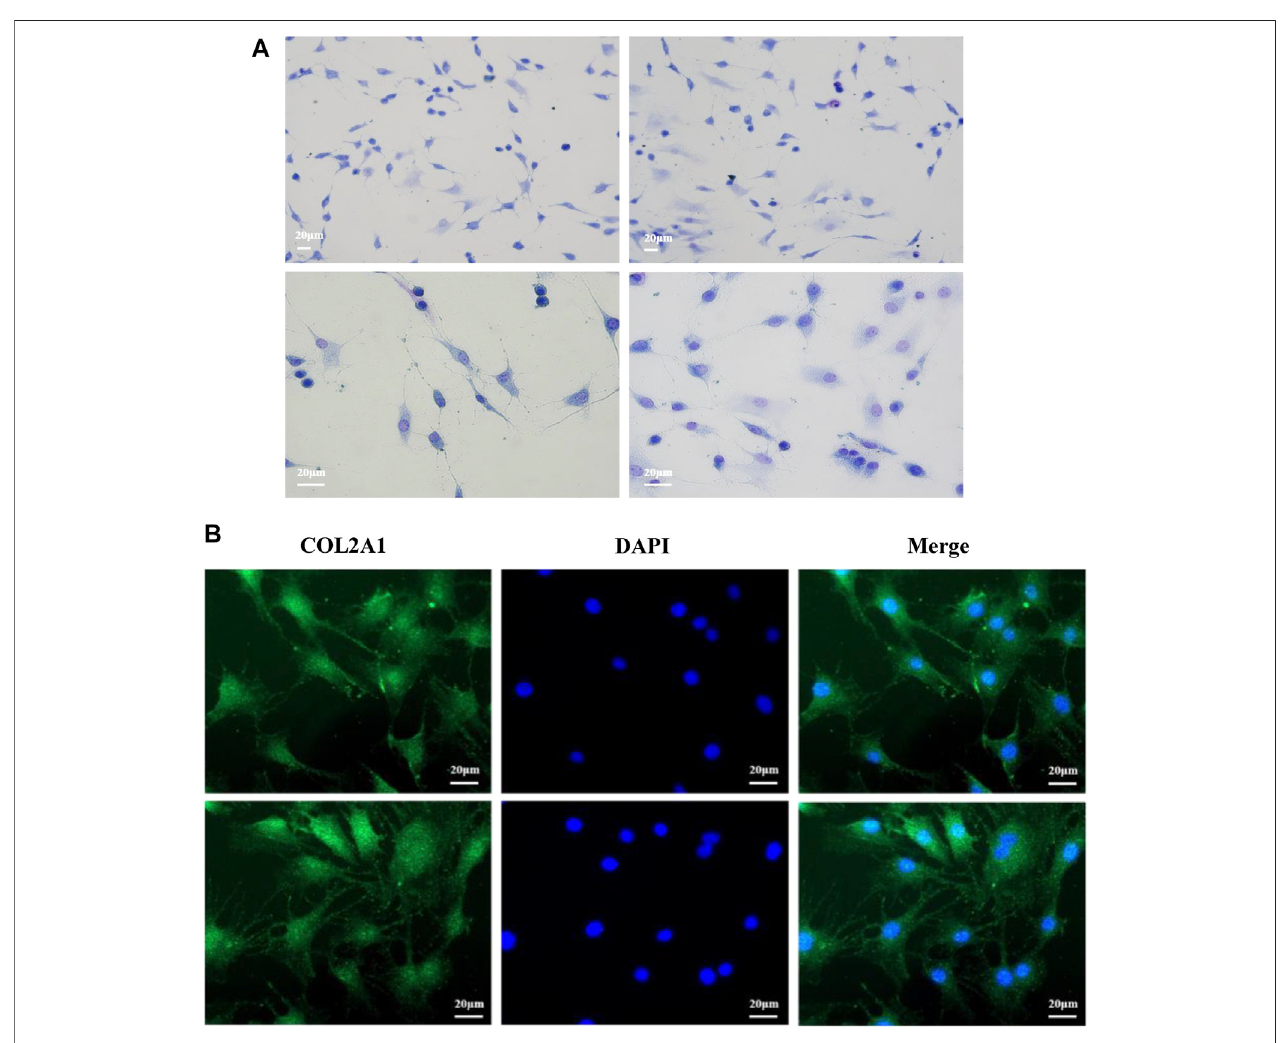
FIGURE 1 | Morphological identi fi cation of bovine chondrocytes. (A) Toluidine blue staining of bovine chondrocytes. (B) Type II collagen α 1 immunohistochemical staining.